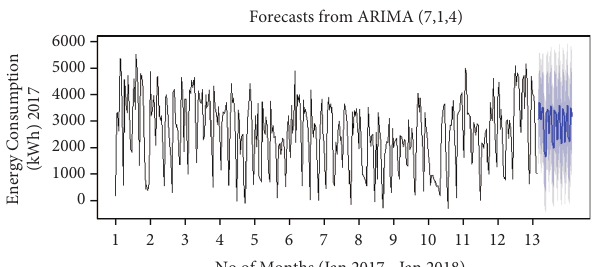
Figure 16: Diagram showing forecasting of energy consumption of January 2018 based on 2017 energy data by using ARIMA (7, 1, and 4) order.